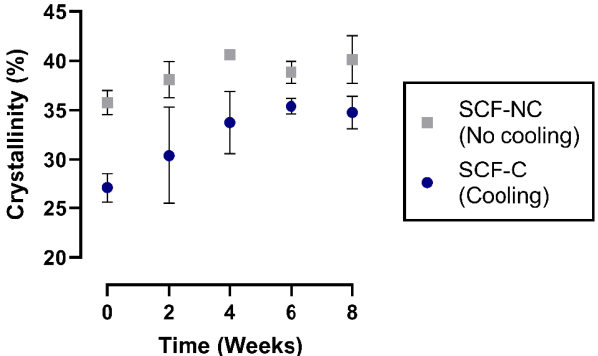
Figure 9. Crystallinity percentage of the scaffolds. In both instances, the degree of crystallinity increases, 14.3% for the SCF-C group, and 5.2% for the SCF-NC group by week 8.